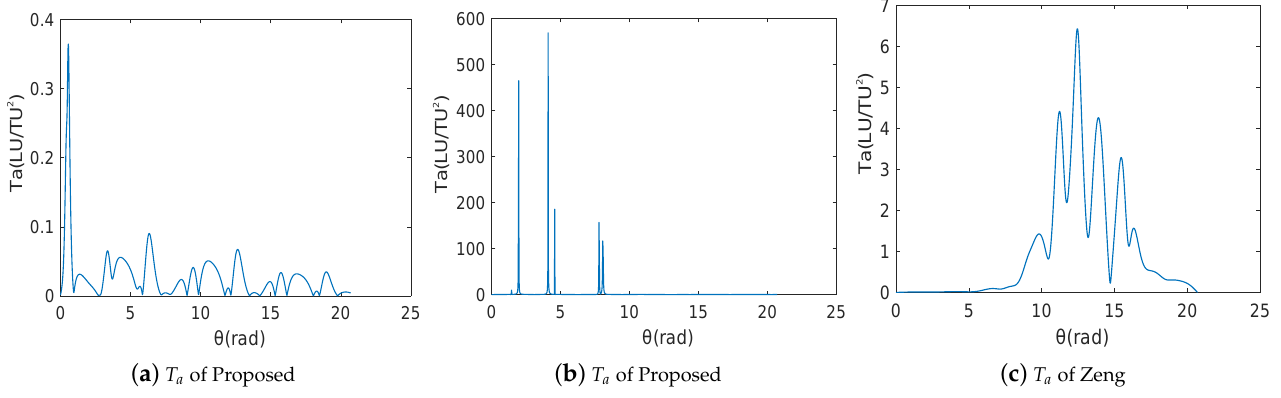
Figure 7. Thrust acceleration T a of each method when r 1 > r 2